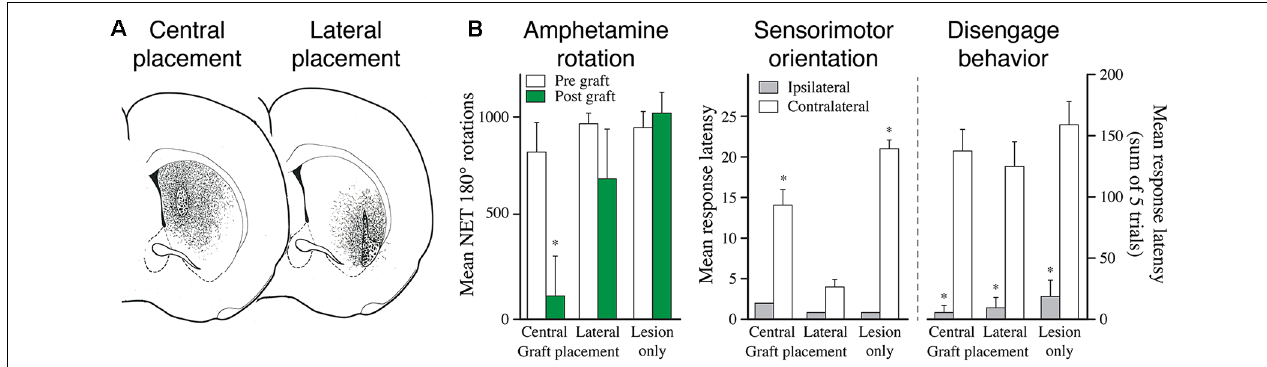
FIGURE 5 | The functional effect depends on the area of the striatum reinnervated by the fetal DA neuron transplants. (A) The reinnervation obtained from VM cell suspension grafts placed in the central or lateral part of the striatum is restricted to the area surrounding the graft deposits. (B) Grafts reinnervating the central vs. lateral striatum, as shown in panel (A) , have markedly different effects on behavior: the centrally placed grafts abolish amphetamine-induced rotation but have little effect on sensorimotor behavior. The laterally placed grafts, by contrast, has little effect on amphetamine rotation but is highly efficient in restoring sensorimotor behavior. The more complex version of the task, called diseagage behavior, remains unaffected by these transplants but is well restored in animals with more wide-spread reinnervation of the striatal complex, as shown in Figure 6 . Modified and redrawn from Mandel et al. (1990). ∗ p < 0.01.